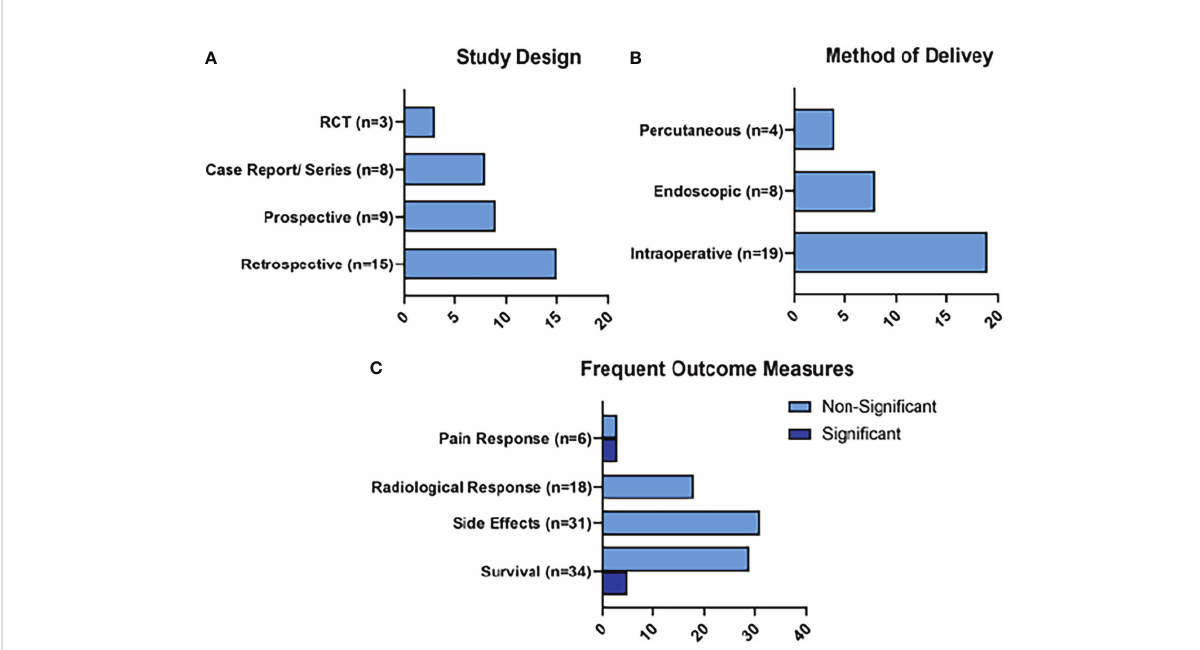
FIGURE 4 Summary of RFA Results. Figure 4 represents the main characteristics of the RFA studies included in this review in terms of study design (A) , method of delivery of RFA (B) , and frequent outcome measures (C) . Frequent outcome measures are subdivided into those that reached statistical signi fi cance, and those that did